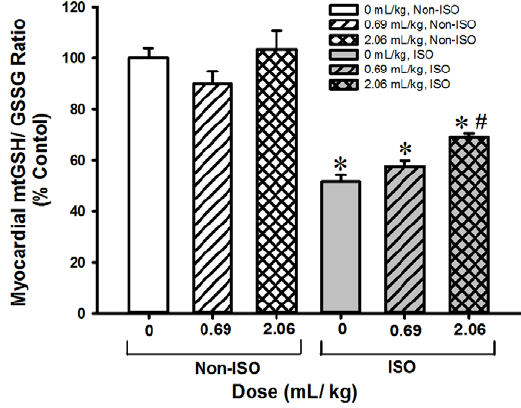
Figure 5. Effects of SOD-Like Supreme treatment on myocardial mitochondrial GSH/GSSG ratio in ISO-challenged mice. After treatment of ISO-challenged mice with SOD-Like Supreme, myocardial mitochondrial GSH/GSSG ratios were measured, as described in Materials and Methods. The GSH/GSSG ratio of the non-ISO control group is 14.7 ± 0.6 (mean ± SEM). Data are expressed as % of the non-ISO controls by normalizing relative to the value of the non-ISO control group. Values given are means ± SEM, with n ≥ 9. * Significantly different from the non-ISO controls; # Significantly different from the ISO control